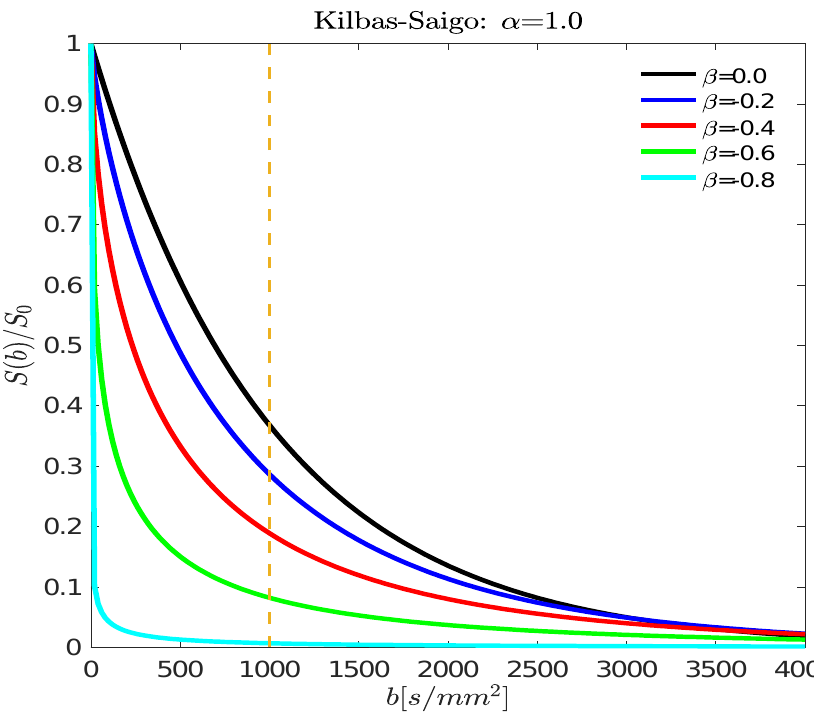
Figure 5. The normalized stretched Kilbas-Saigo signal decay of S(b) / S 0 is plotted versus b -values between 0 and 4000 s / mm 2 , and D 0 = 1 × 10 − 3 mm 2 / s with α = 1, and β = 0, − 0.2, − 0.4, − 0.6, and − 0.8. The signal decay in the α = 1 case is a weighted stretched exponential. As the value of β decreases, the shape of the decay curve transitions from a stretched exponential decay to a pattern with a asymptotic power law decay.